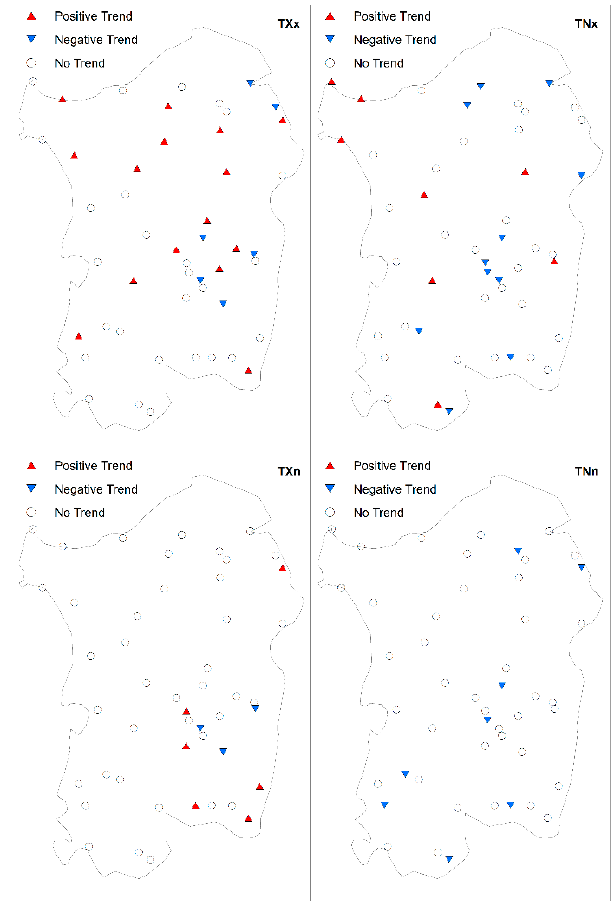
Figure 7. Spatial distribution of extreme temperature indices trend (TXx, TNx, TXn and TNn; see Table 3 for abbreviation definitions).